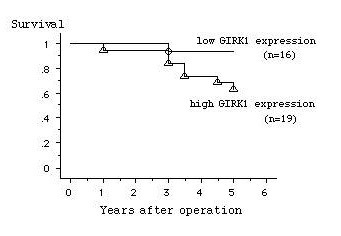
Survival curves of the patients with stage I NSCLC on the basis of GIRK1 amplification. A significant difference was seen between the 2 groups (p = 0.0376).